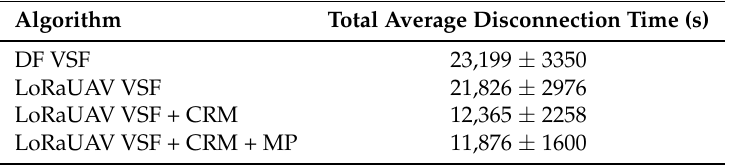
Table 5. Total average disconnection time and relative confidence interval obtained with different algorithm